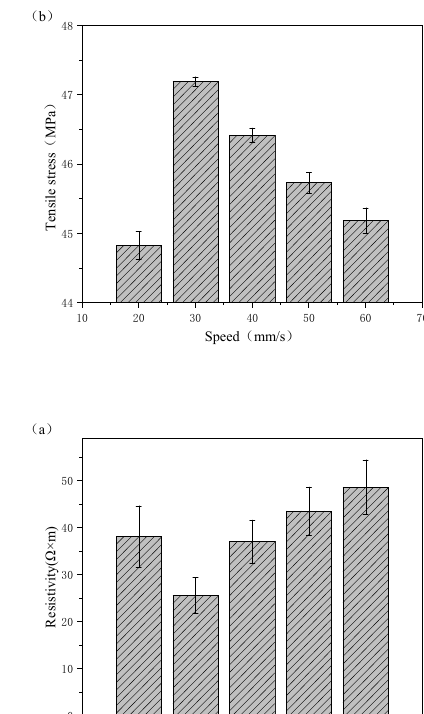
Figure 6. Effect of printing temperature on the ( a ) flexural modulus, ( b ) tensile strength, ( c ) impact strength, and ( d ) volume resistivity of printed samples.